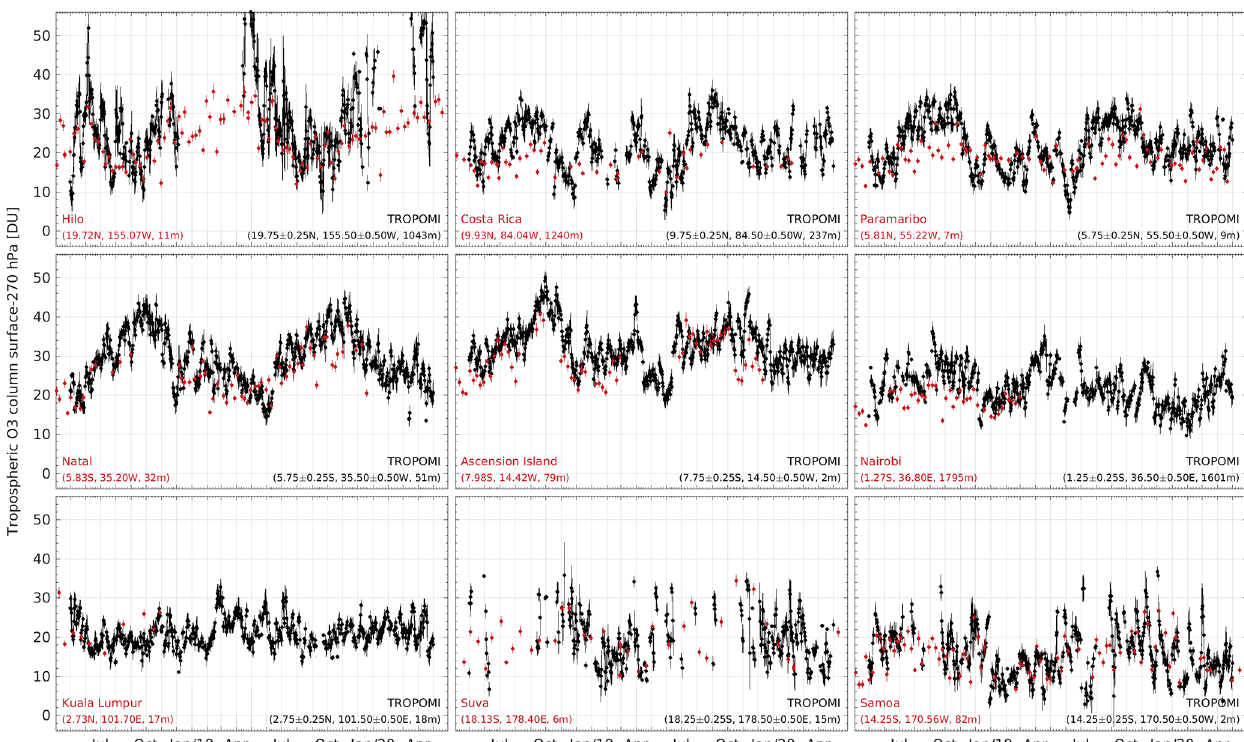
Figure 2. Time series of spatially co-located TROPOMI (black) and ozonesonde (red) tropospheric ozone column data over nine SHADOZ